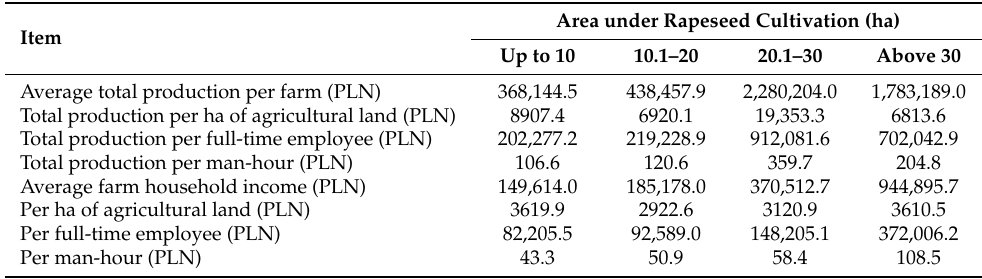
Table 7. Total production and farm household income values for the analyzed farms with different area under rapeseed cultivation rates.